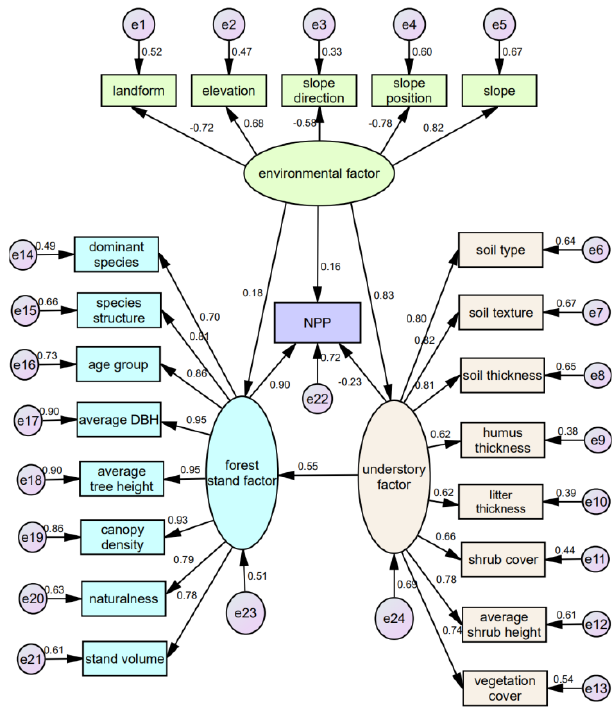
Figure 6. Schematic diagram of NPP structural equation model in Shaoguan in